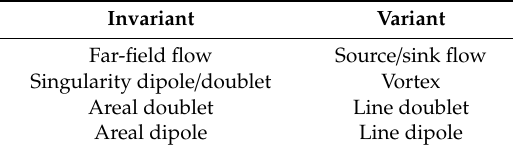
Table 1. Invariant and variant complex